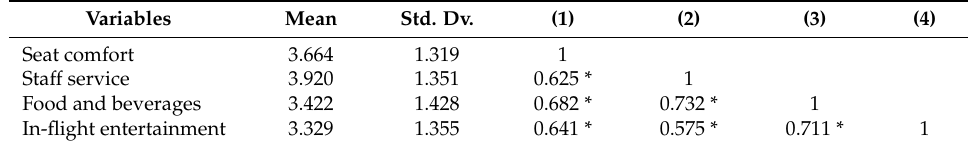
Table 1. Descriptive statistics and correlations between predictors.